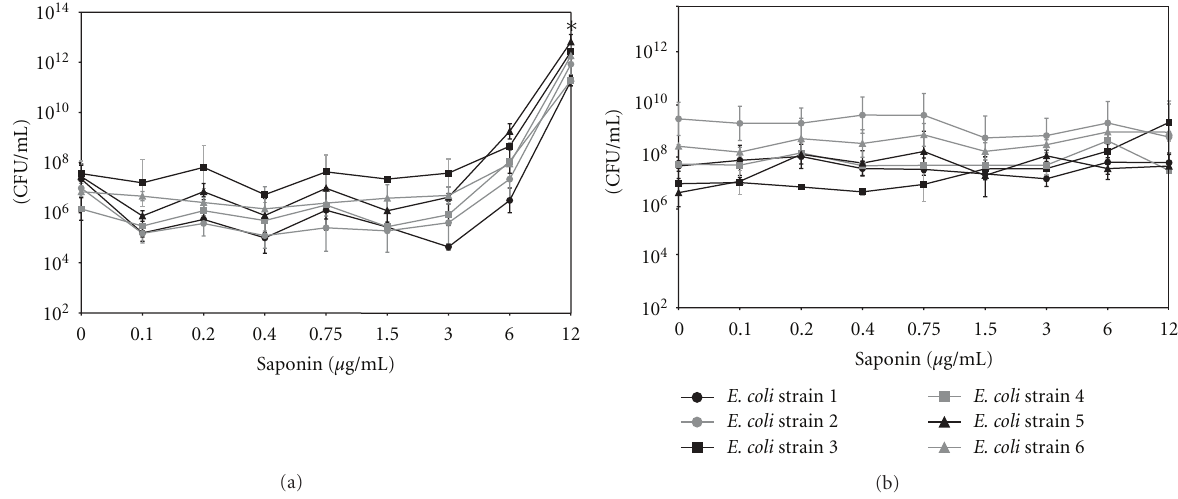
Figure 3: The e ff ect of saponin on the growth of the E. coli strains incubated for 18h at 37 ◦ C in LB (a) and M9 medium (b); mean of three independent experiments ± SD. ∗ P < 0 .